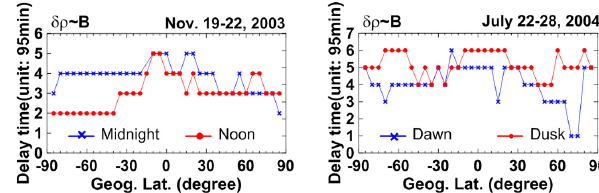
Fig. 12. Examples of latitudinal variation of delay time of mass density changes in respect to IMF B for different LT sectors dur- ing magnetic storms of 19–22 November 2003 (left) and 22– 28 July 2004